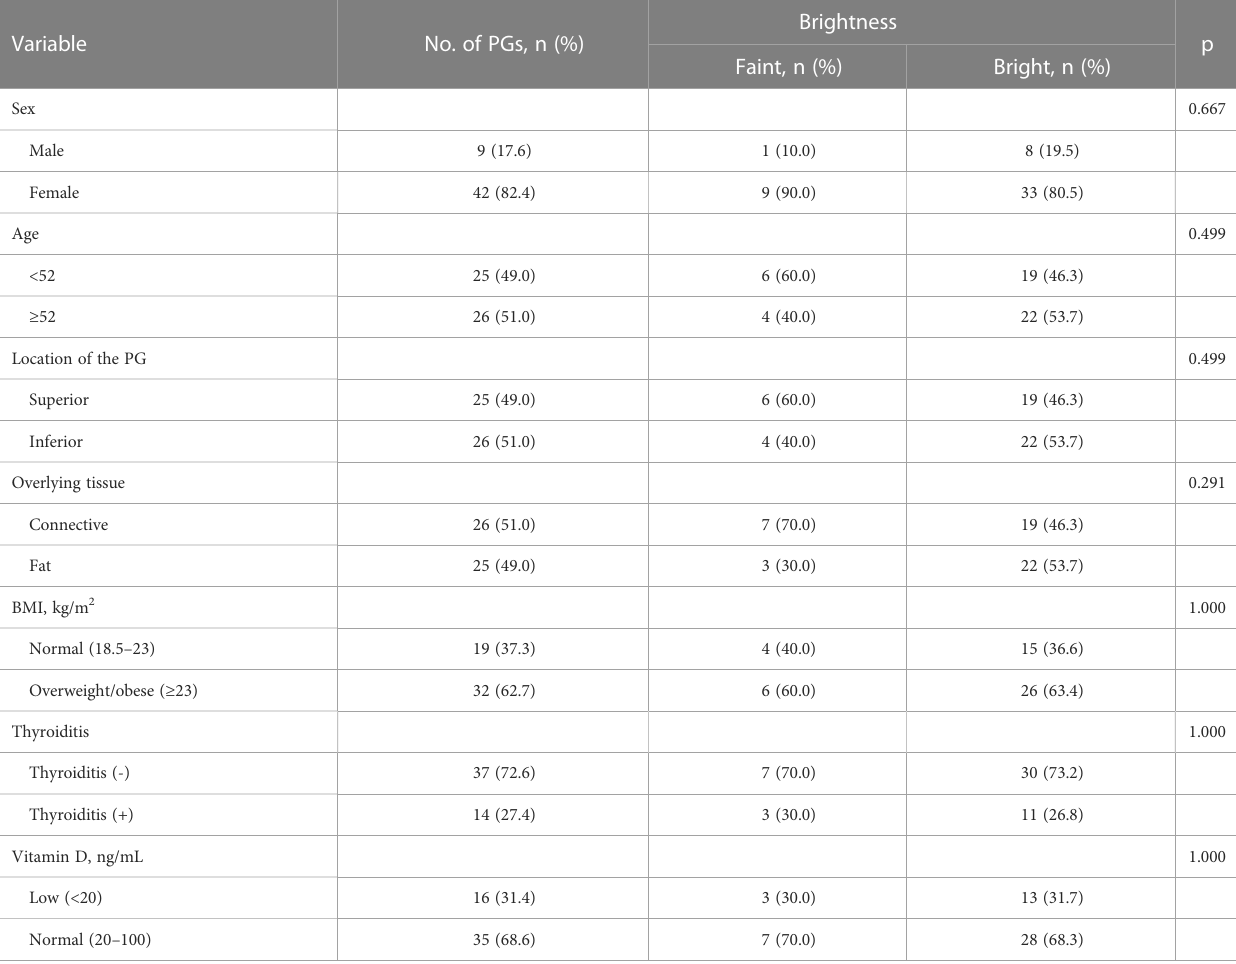
TABLE 2 Correlations between brightness and other